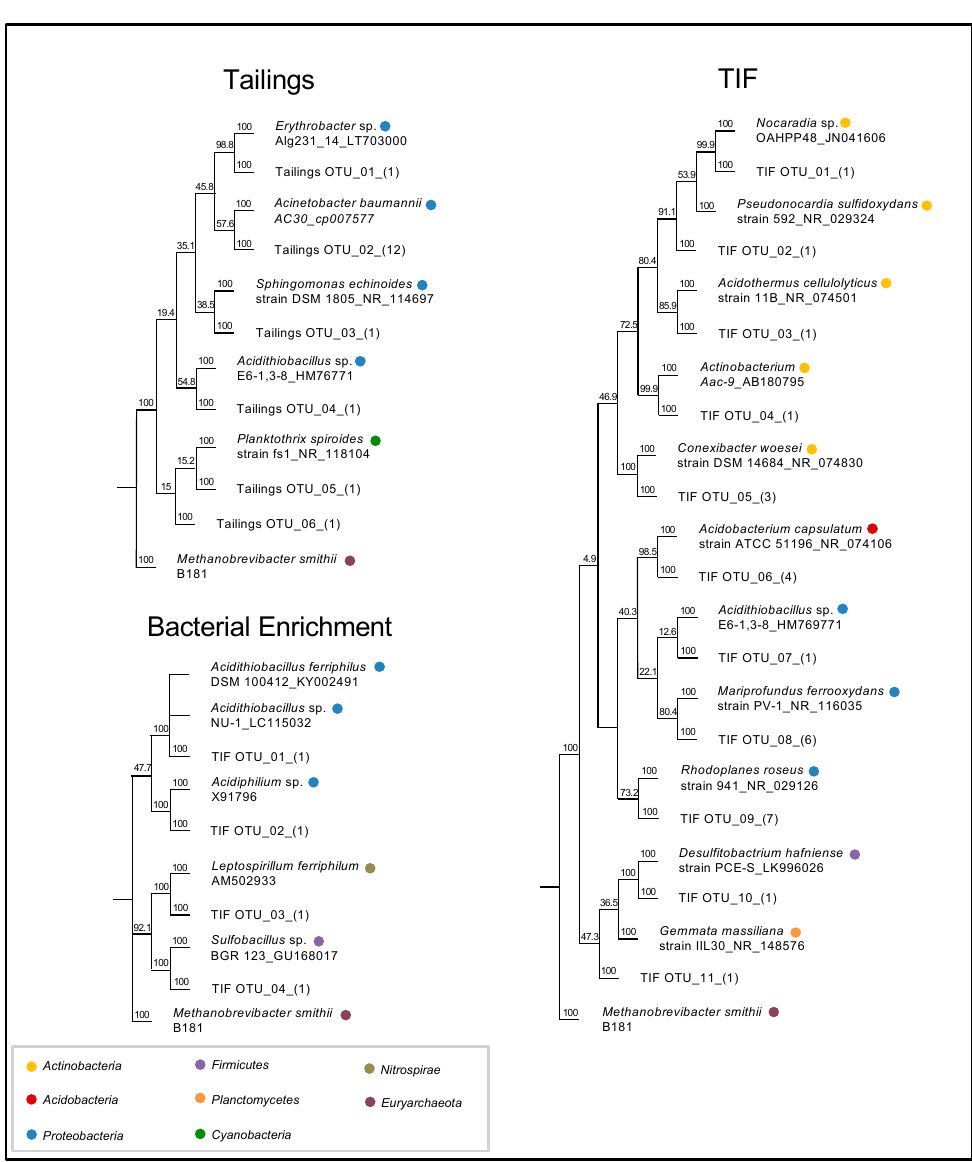
Figure 3. A neighbor-joining phylogenetic tree of the bacterial species based on (OTUs) from the tailing, TIF, and bacterial enrichment samples.